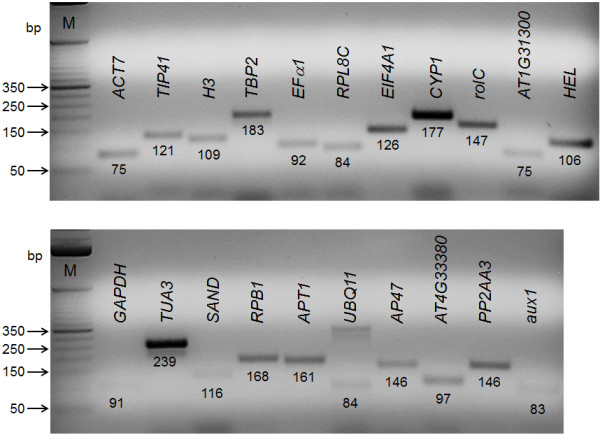
Performance of primer amplification. Amplicons obtained from qPCR endpoint analysis were separated by agarose gel electrophoresis. Target genes corresponding to test primer sets are indicated above the amplicon and the expected size in base pairs (bp) of each amplicon is shown.